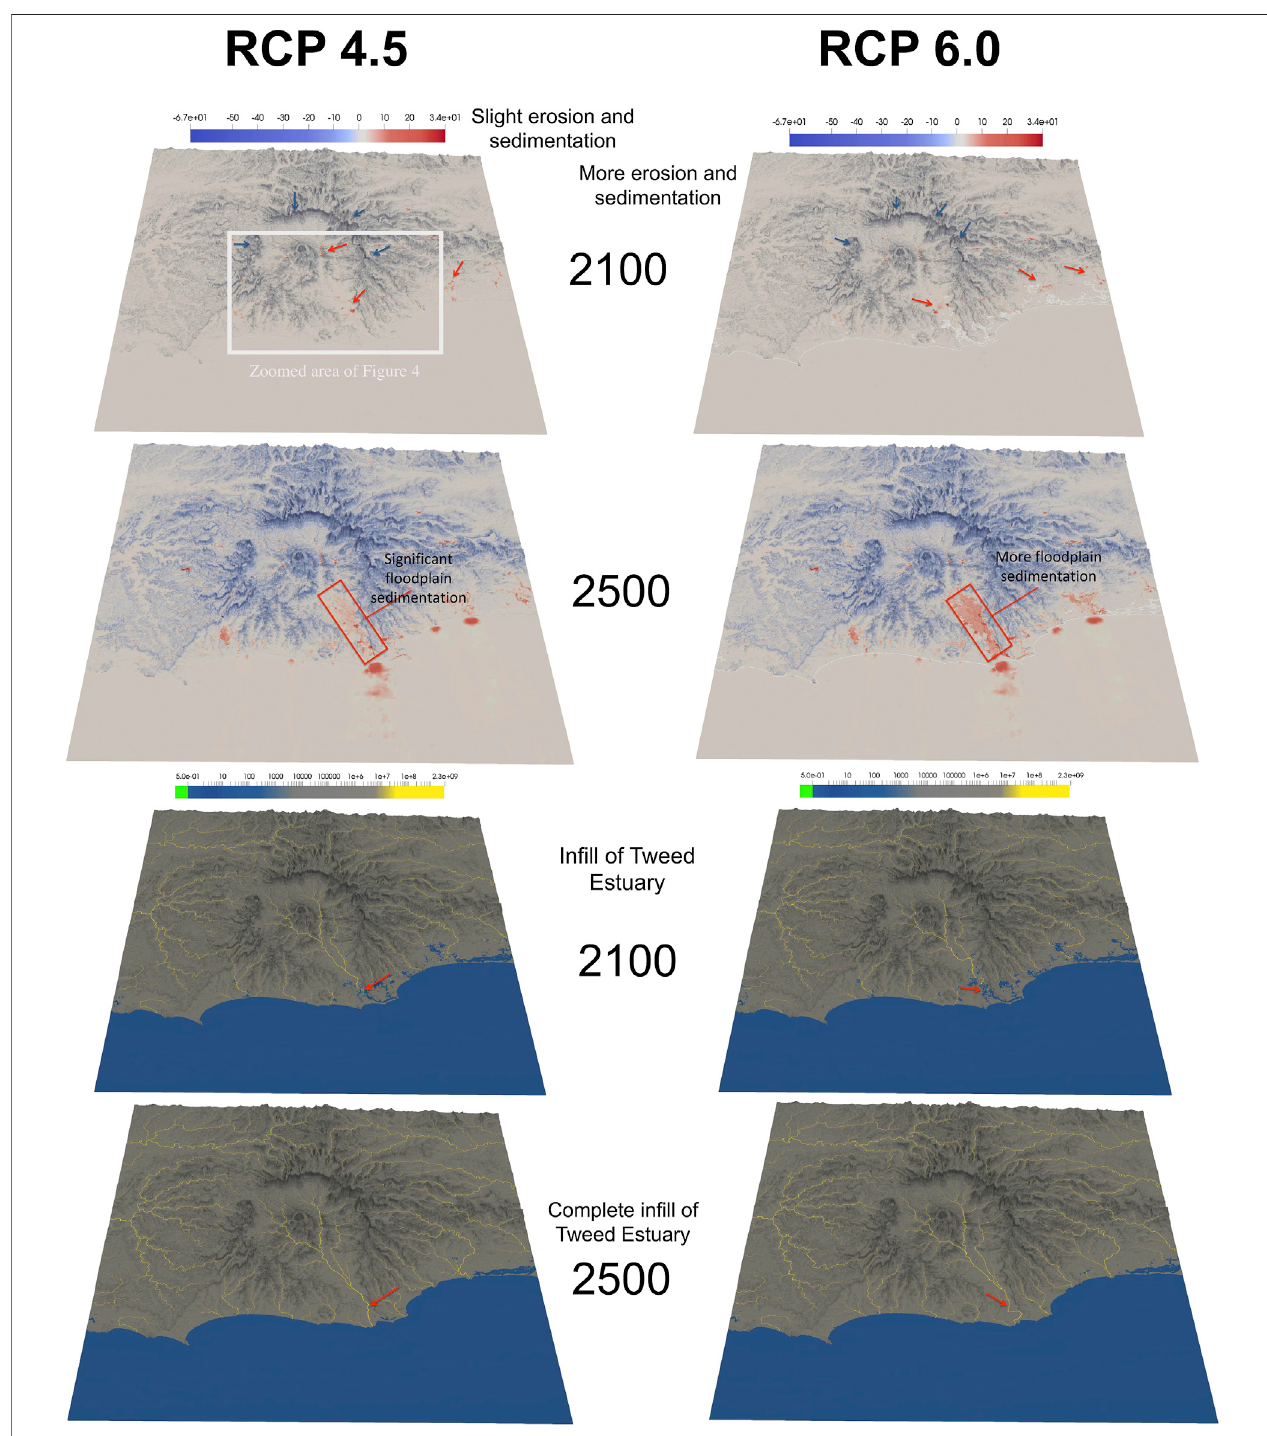
FIGURE 3 | Comparison of (Representative Concentration Pathways) RCP 4.5 and RCP 6.0. Visualizations of erosion/deposition with red regions indicating areas of deposition and blue regions indicating areas of erosion (m 2 /a) (top) . Visualizations of discharge with brighter yellow colors indicating greater discharge rates (m 2 /a) (bottom) , with varying impacts between scenarios and over time.